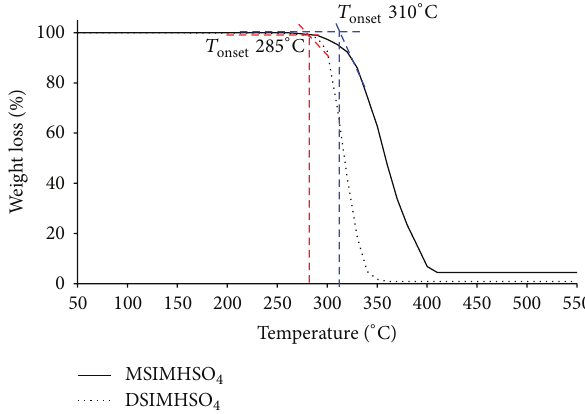
Figure 5: Thermogravimetric analysis (TGA) curves of the thermal decomposition of DSIMHSO 4 and MSIMHSO 4